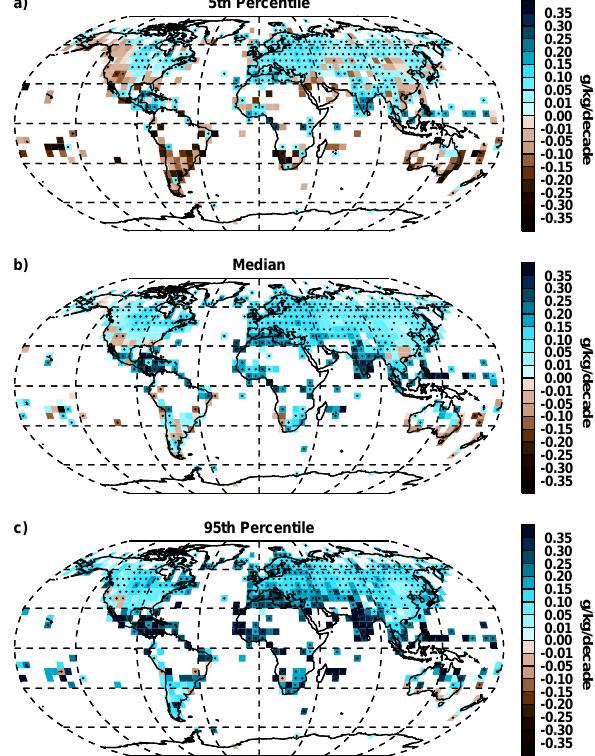
Fig. 12. Exploration of the uncertainty in decadal trends using 100 realisations of HadISDH spread across the 2 σ uncertainty esti- mates. Median pairwise trends were fitted over the period for each realisation, with higher confidence assigned by a black dot as de- scribed in Fig. 9. For each grid box, the 5th percentile (a) , median (b) and 95th percentile (c) trends are shown. If the uncertainty was large enough to obscure the long-term trends, then it would be ex- pected that the 5th and 95th percentiles would starkly disagree with each other. In fact, there is very little difference as shown by (a) , (b) and (c) above. Note non-linear